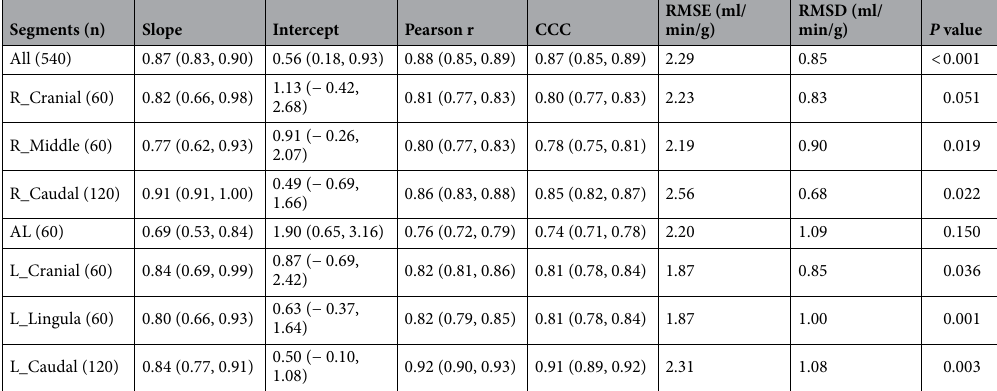
Table 4. Regression of simulated two-volume prospective FPA perfusion versus retrospective FPA perfusion. Data in parentheses are 95% confidence intervals. P values less than 0.05 indicate significant difference. CCC: concordance correlation coefficient, RMSD: root-mean-square deviation, RMSE: root-mean-square error, AL: accessory lobe, R: right lung, L: left lung.